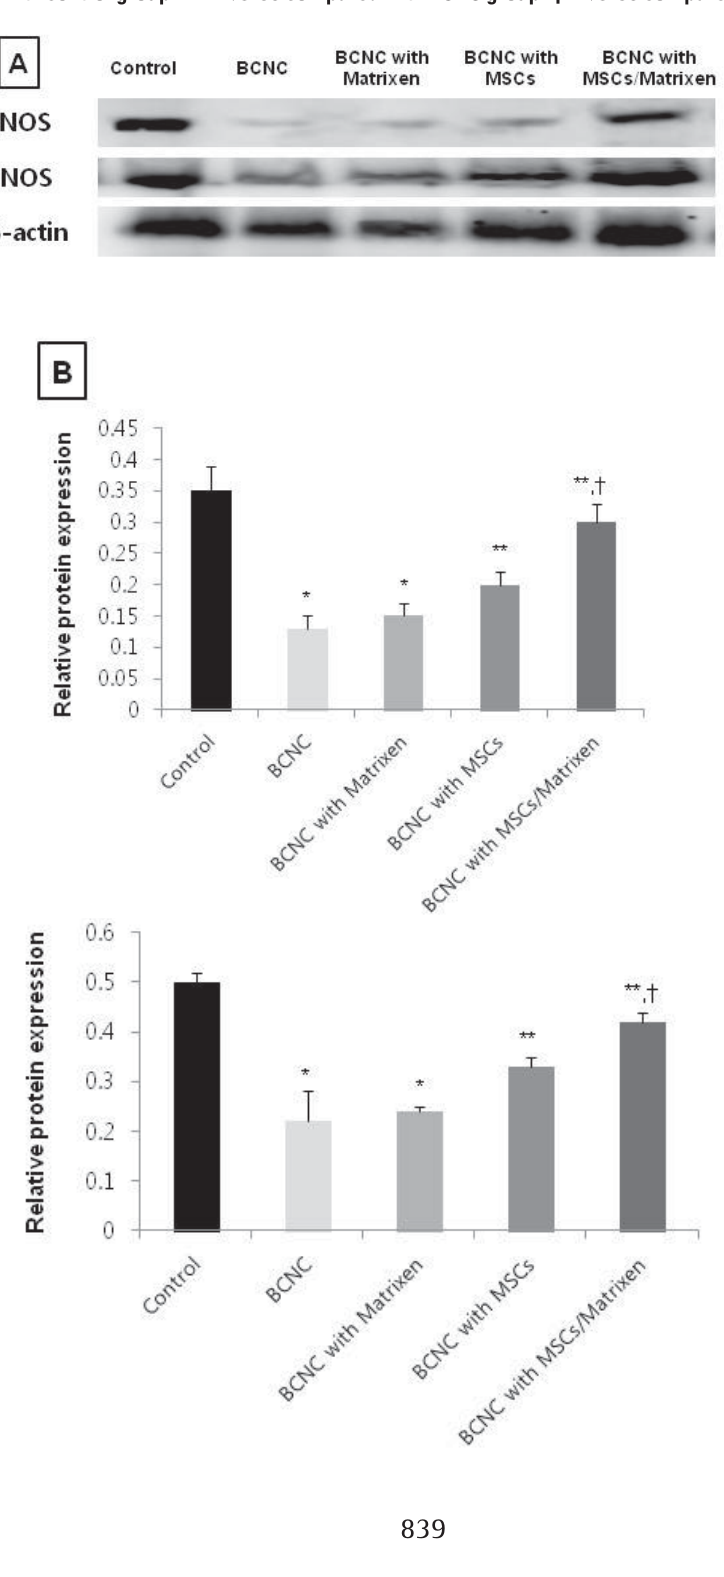
Figure 4 - Westerm blot analysis of eNOS and nNOS in corpus cavernosum at 4 weeks control, bilateral cavernous nerve crushing (BCNC), BCNC with Matrixen, BCNC with mesenchymal stem cells (MSCs), BCNC with MSCs mixed with Matrixen group (A). Densimetric analysis to β -actin of eNOS and nNOS (B). *P < 0.05 compared with control group. **P < 0.05 compared with BCNC group. †P < 0.05 compared with BCNC with MSCs